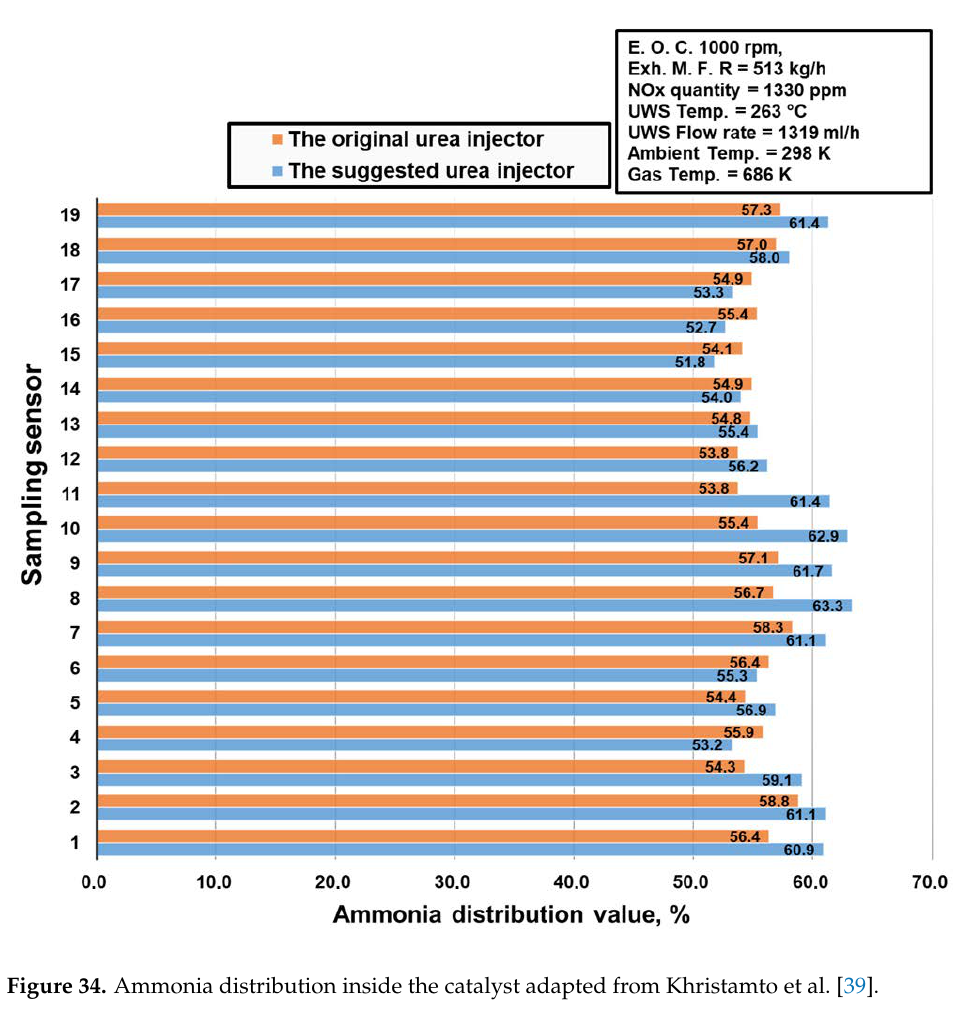
Figure 34. Ammonia distribution inside the catalyst adapted from Khristamto et al. [39].